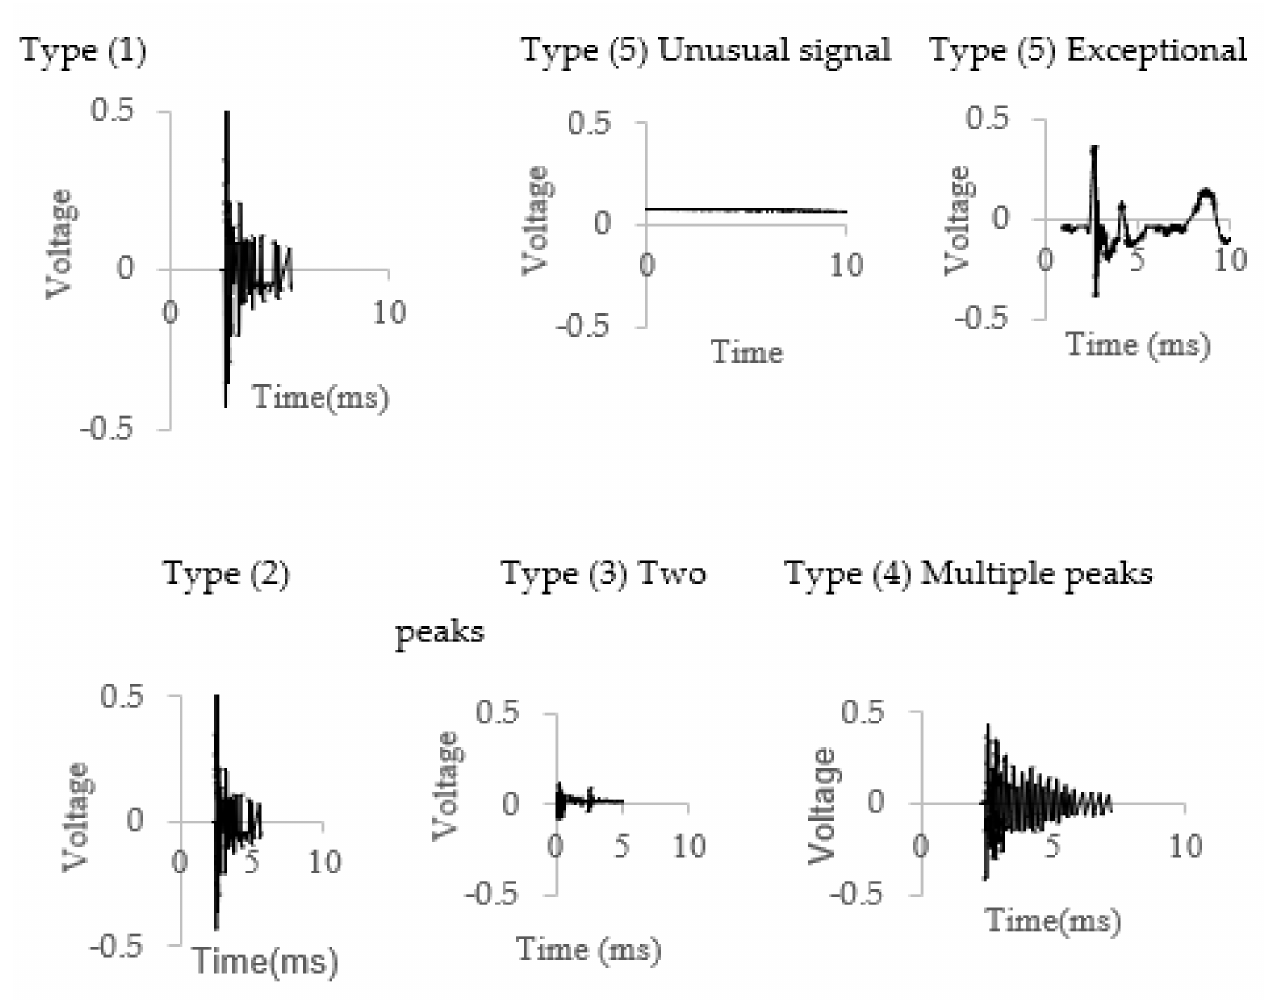
Figure 5. Different type of IE